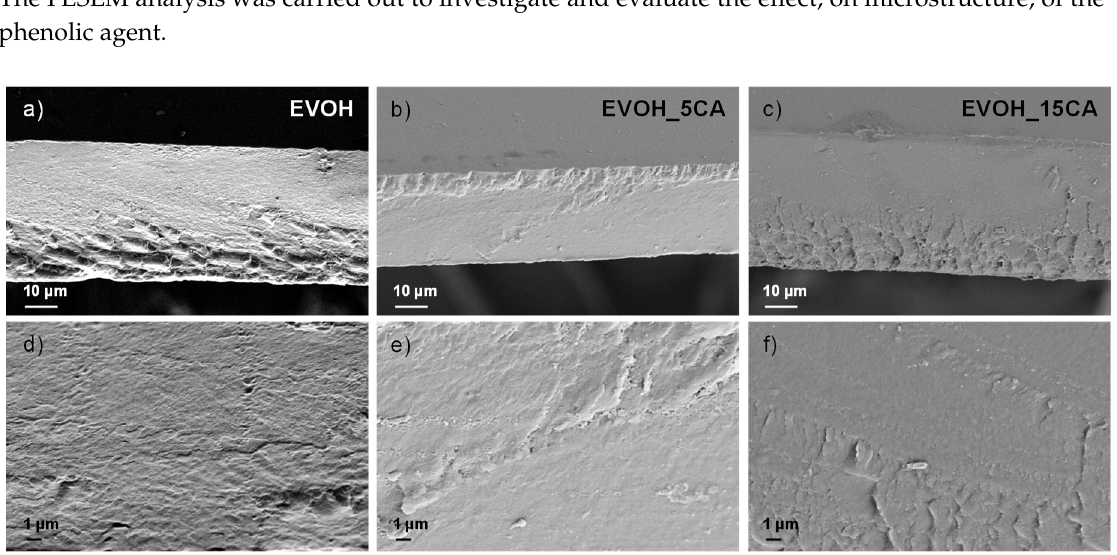
Figure 4. FESEM investigation of fractured surfaces of EVOH based formulations at two different